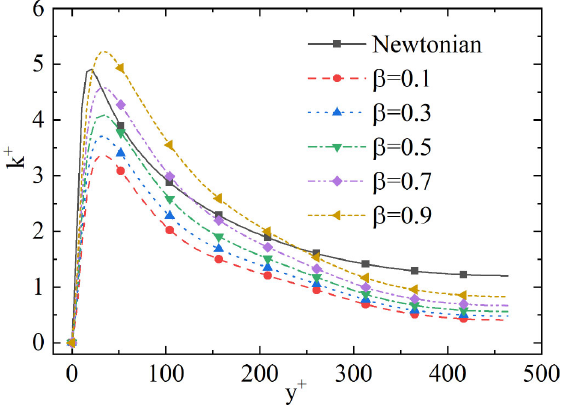
Figure 19. Dimensionless average flow velocity ( U + ) of different solvent viscosity ratios ( β ).